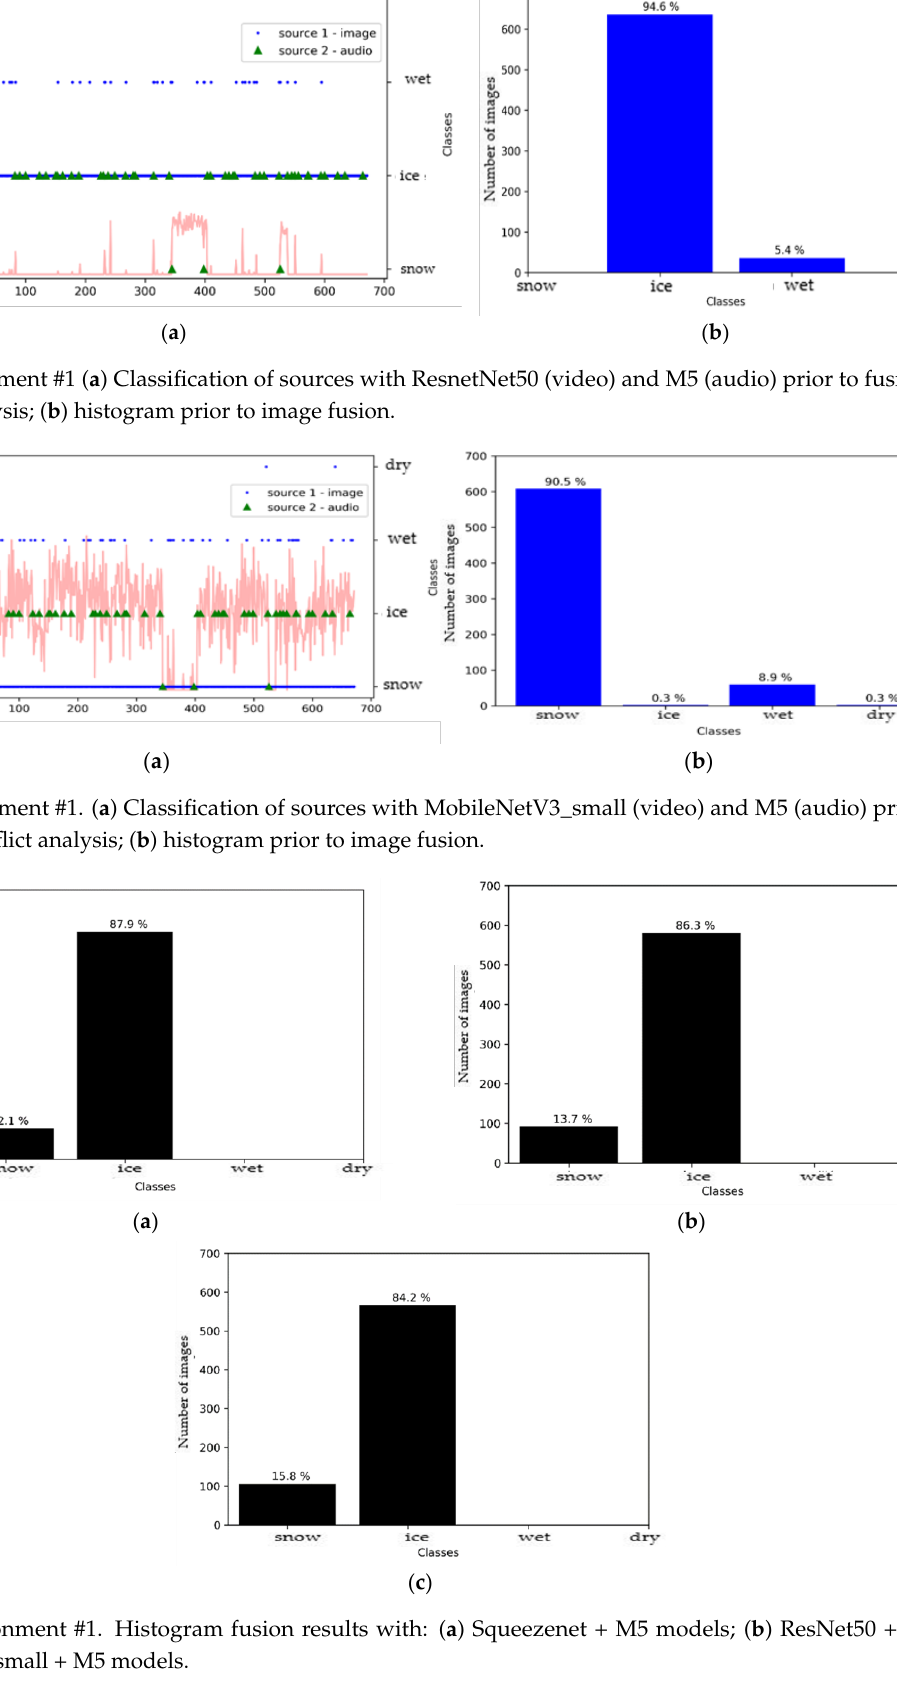
Figure 10. Environment #1. Histogram fusion results with: ( a ) Squeezenet + M5 models; ( b ) ResNet50 + M5 models; ( c ) MobileNetV3_small + M5 models.